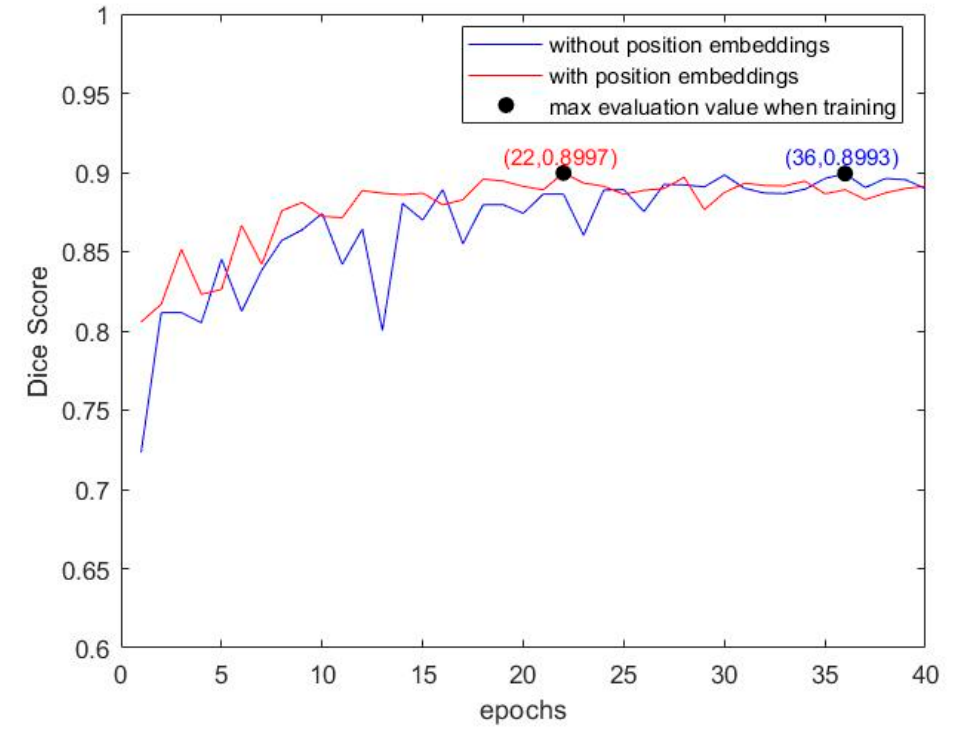
Figure 3. Comparison of model training performance with and without positional embeddings. The max evaluation during training was marked with a solid dot.